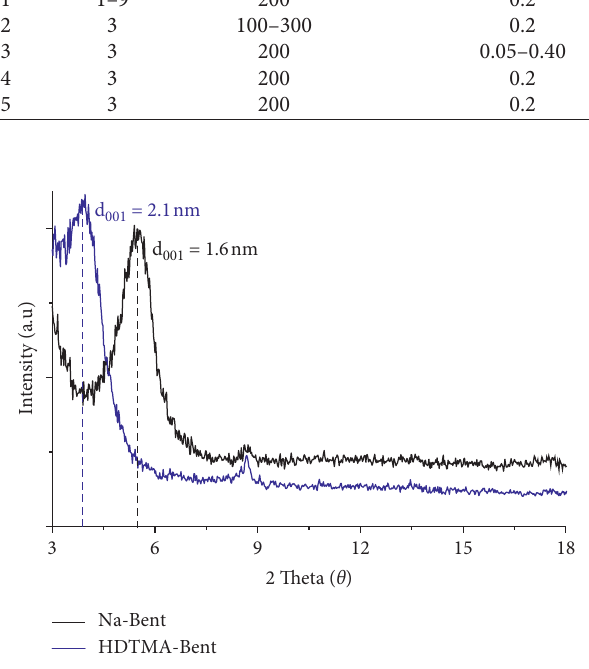
Figure 1: XRD patterns of sodium bentonite (Na-Bent) and organobentonite (HDTMA-Bent).